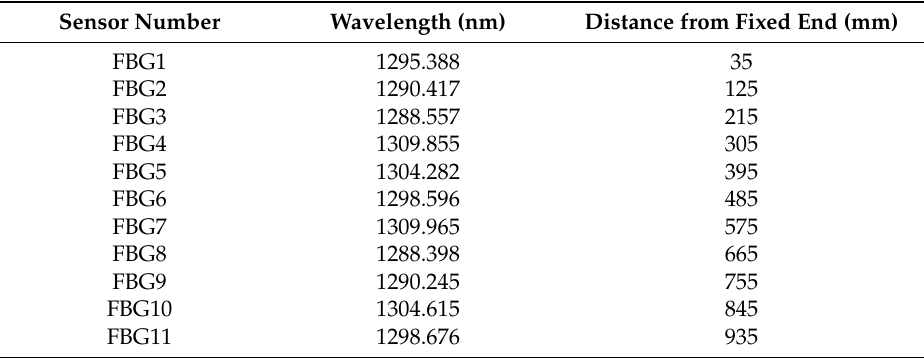
Table 1. The locations of FBG (Fibre Bragg Grating) sensors.